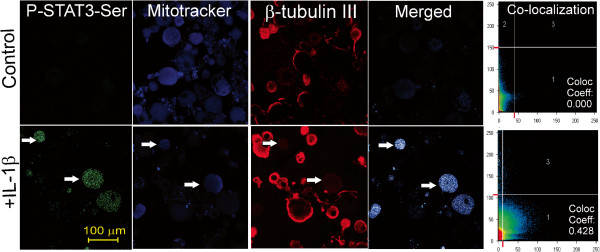
IL-1β induces co-localization of P-STAT-Ser727 with mitochondria in cultured DRG sensory neurons. DRG neurons were stimulated with IL-1β (10 ng/ml) for 30 min and then live cells loaded with MitoTracker deep red and then fixed and co-stained for P-STAT3-Ser727 and β-tubulin III. Confocal images of control (top panels) and IL-1β stimulated neurons (bottom panels) showing the individual channels and the co-localization coefficients between P-STAT3-Ser727 and MitoTracker deep red are shown. White arrows indicate neurons (e.g. positive for β-tubulin III) with P-STAT3-Ser727 and Mitotracker co-localization. Zeis LSM510 software was used to measure the co-localization coefficient; a threshold was set manually and a table of results was generated by the software, as described previously [68]. Co-localization analysis was based upon review of 163 ± 4.1 neurons for each treatment of which 25.3 ± 5.6 neurons (n=3 replicates) exhibited high expression of P-STAT3-Ser727. The overall coefficient for co-localization with Mitrotacker deep red for the high expressing P-STAT3-Ser727 neurons was calculated as 0.432 ± 0.086 (as derived from the Zeiss LSM510 software).